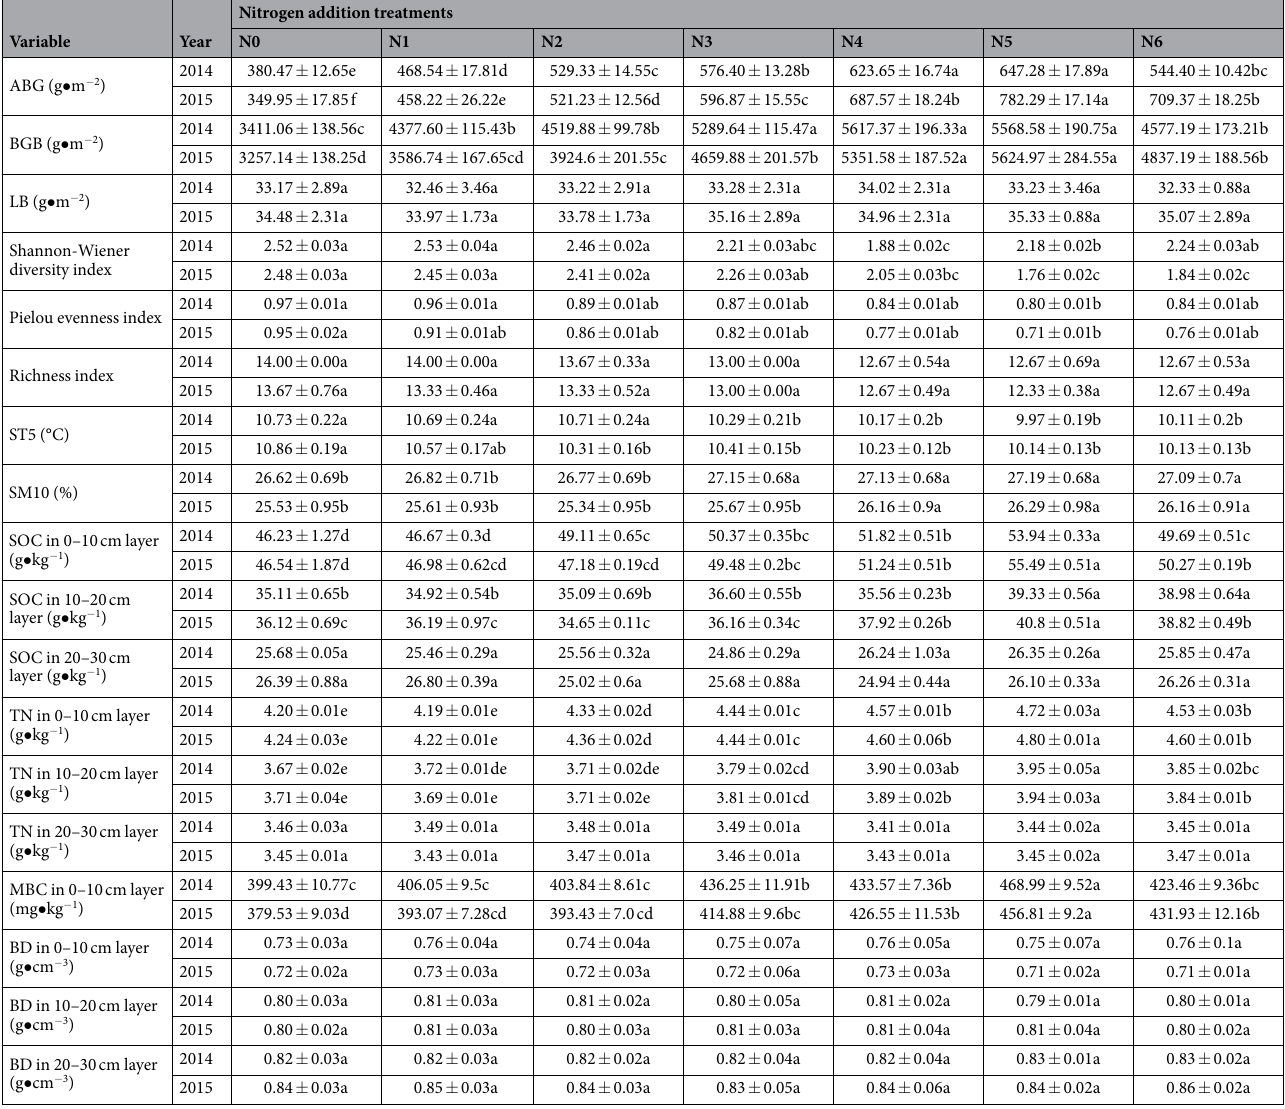
Table 1. The biotic and abiotic variables after 2 and 3 years of nitrogen-addition (2014 and 2015, respectively) in an alpine meadow ecosystem on the northeast margin of the Qinghai-Tibetan Plateau. Note: N0, N1, N2, N3, N4, N5 and N6 represent 0, 54, 90, 126, 144, 180 and 216 kg N ha − 1 yr − 1 , respectively. Data are showed as the means ± standard error. Different letters in the same row indicate significant differences at P < 0.05. The belowground biomass was calculated for the 0–30 cm depth. ABG: Aboveground biomass; BGB: Belowground biomass; LB:Litter biomass; MBC: Microbial biomass carbon; SM10: Volumetric soil moisture content at 10 cm depth; ST5: Soil temperature at 5 cm depth; SOC: Soil organic carbon; TN: Soil total nitrogen; BD: Soil bulk